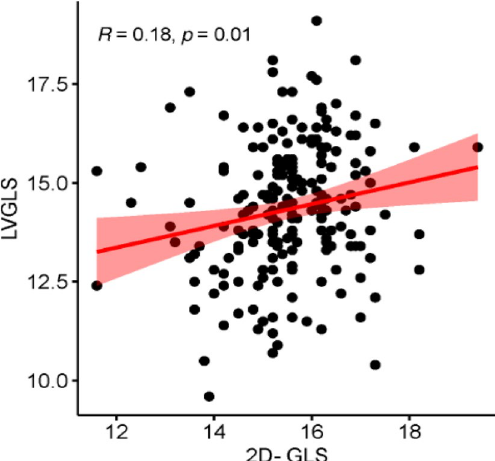
Figure 2. Correlation analysis of LVGLS with 2D-GLS. LVGLS, left ventricular global longitudinal strain; 2D-GLS, two dimensional global longitudinal strain.